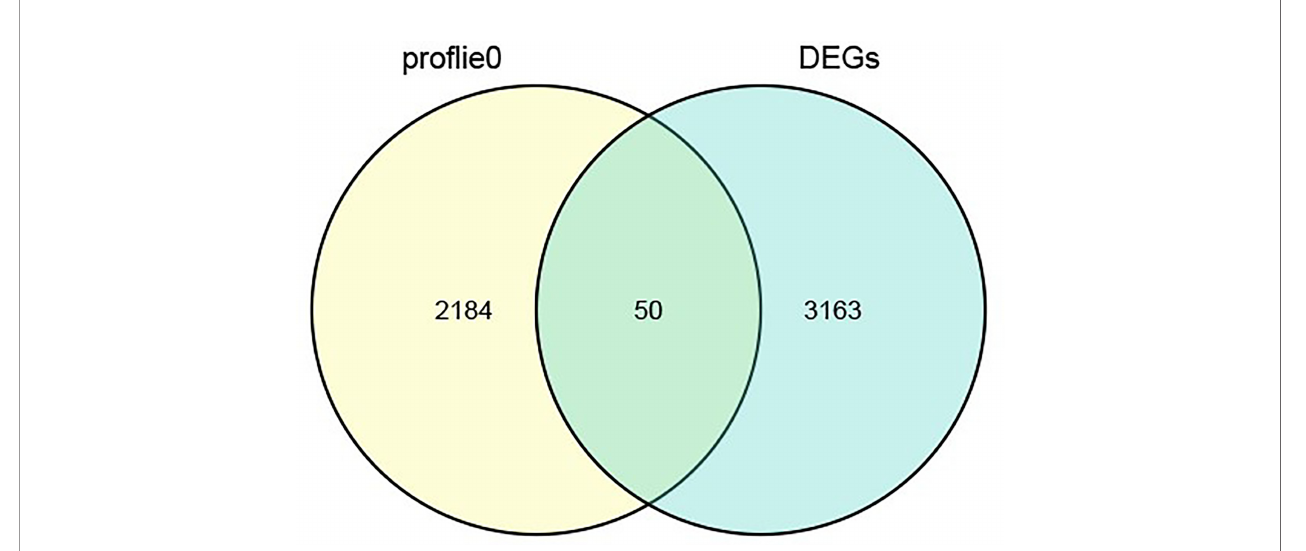
FIGURE 3 | Venn diagram of the